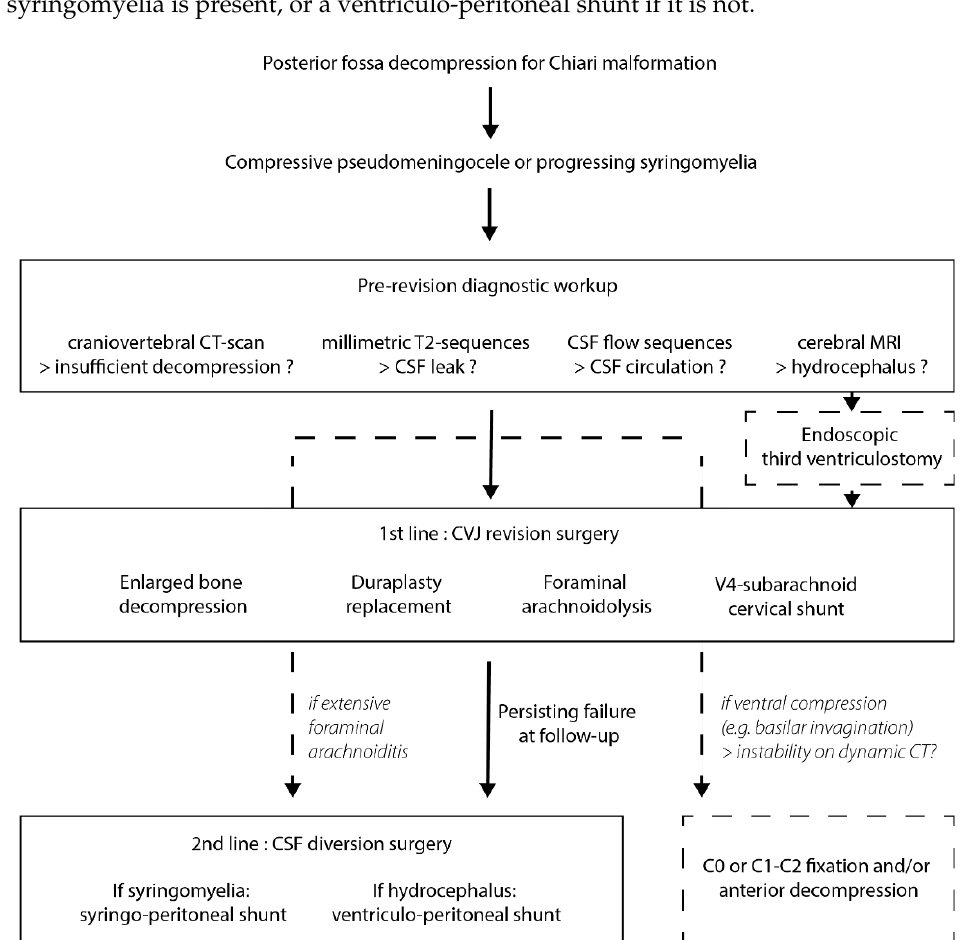
Figure 4. Proposed algorithm for managing Chiari decompression failure.